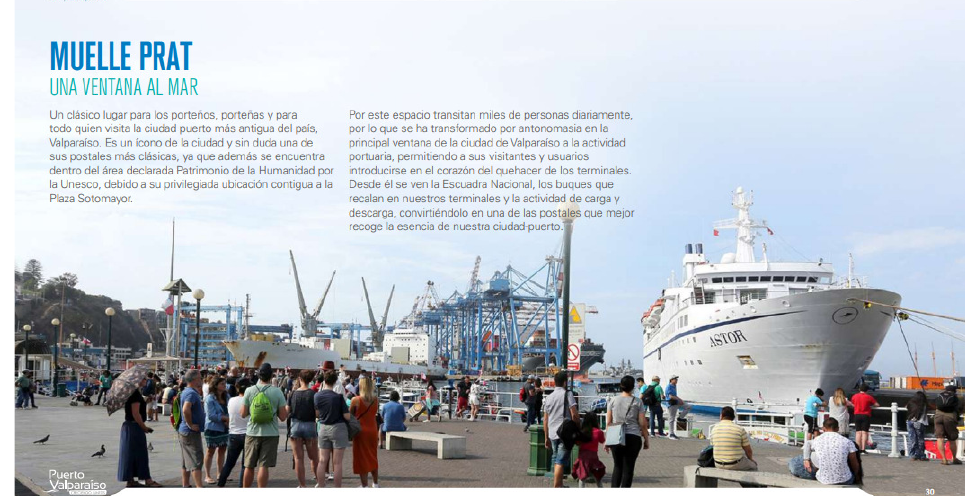
Figure 5. Muelle Prat (Prat Pier): A window to the sea. Source: Empresa Portuaria Valparaíso (2020).